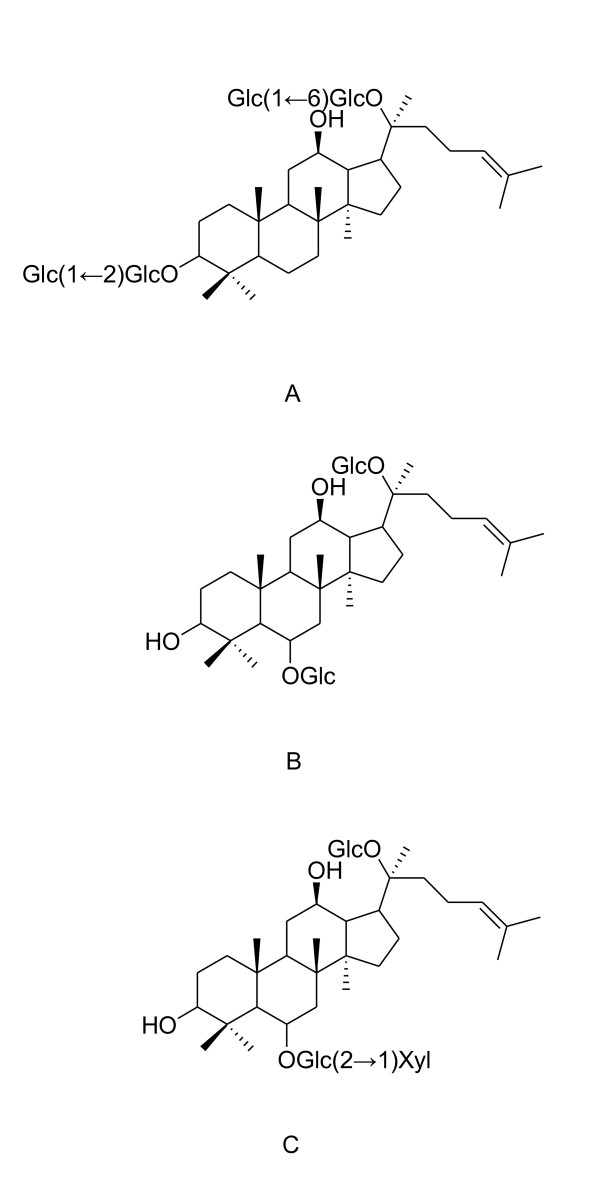
Chemical structures of Ginsenoside Rb1 (A), Ginsenoside Rg1 (B) and Notoginsenoside R1 (C).